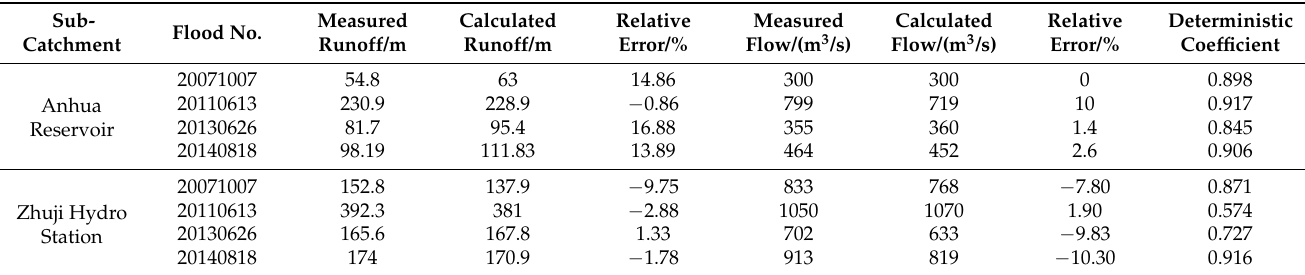
Table 5. Validation results of the Xin’anjiang model.